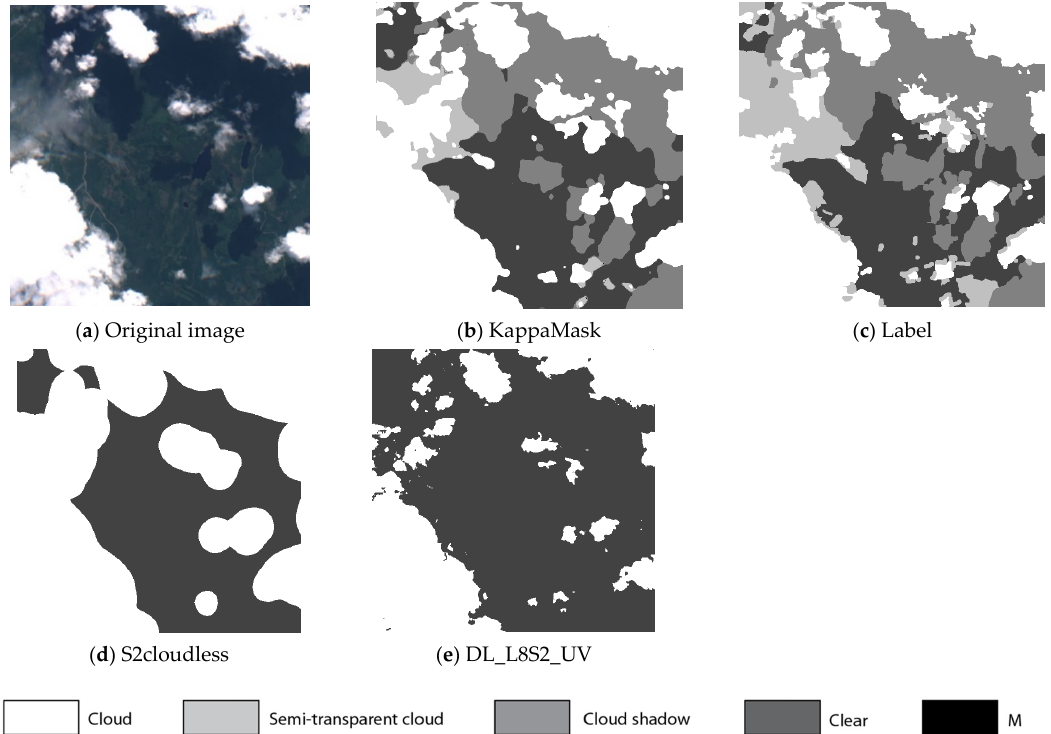
Figure 10. Comparison of L1C prediction output for a 512 × 512 pixels sub-tile in the test dataset. ( a ) Original Sentinel-2 L1C True-Colour Image; ( b ) KappaMask classification map; ( c ) Segmentation mask prepared by a human labeller; ( d ) S2cloudless classification map; ( e ) DL_L8S2_UV classification map.